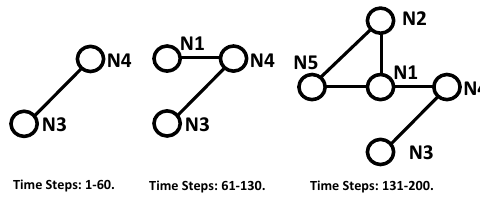
Figure 12. The time-varying topology for different time steps.